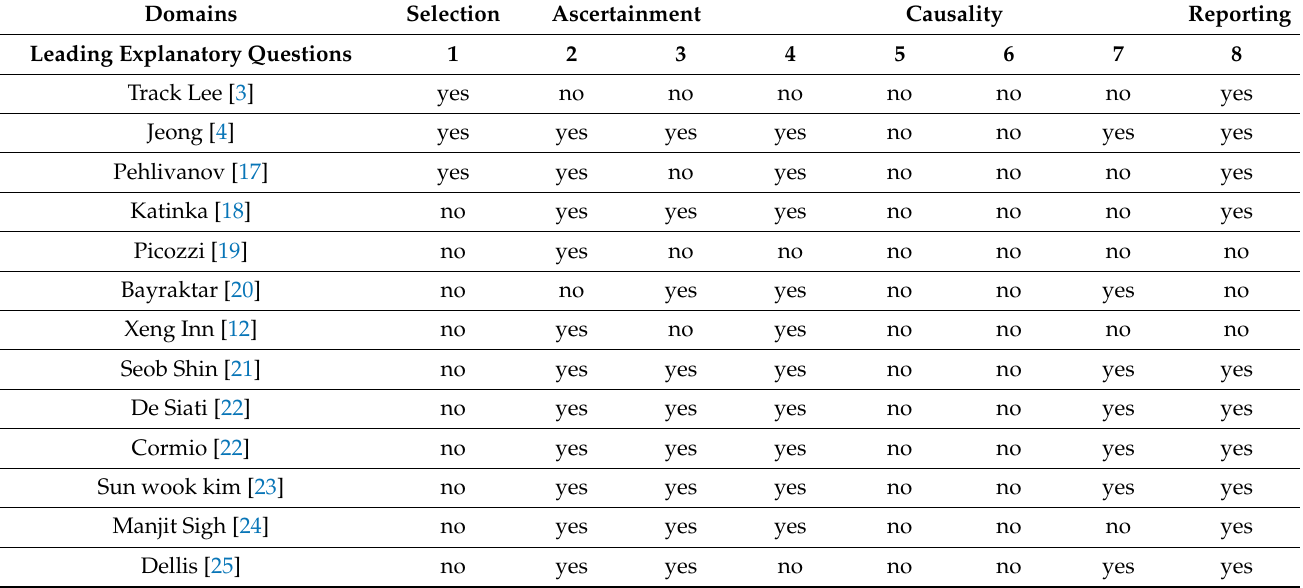
Table 1. Methodological quality of case reports and case series according to Murad et al. [16]. Domains Selection Ascertainment Causality Reporting Leading Explanatory Questions 1 Track Lee [3]